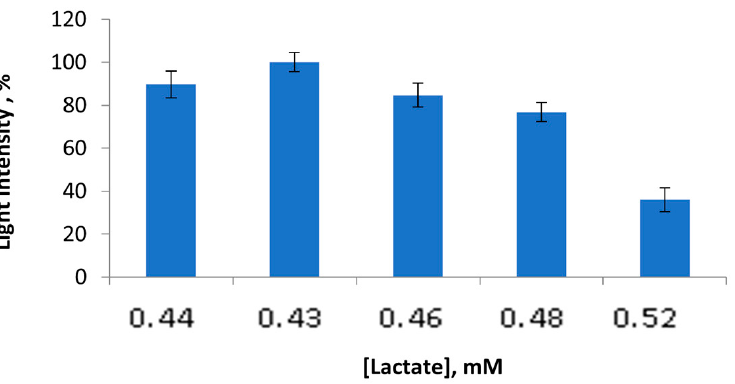
Figure 2. Values of light intensity of the LDH + Red + Luc enzyme system upon the lactate concentration variation.